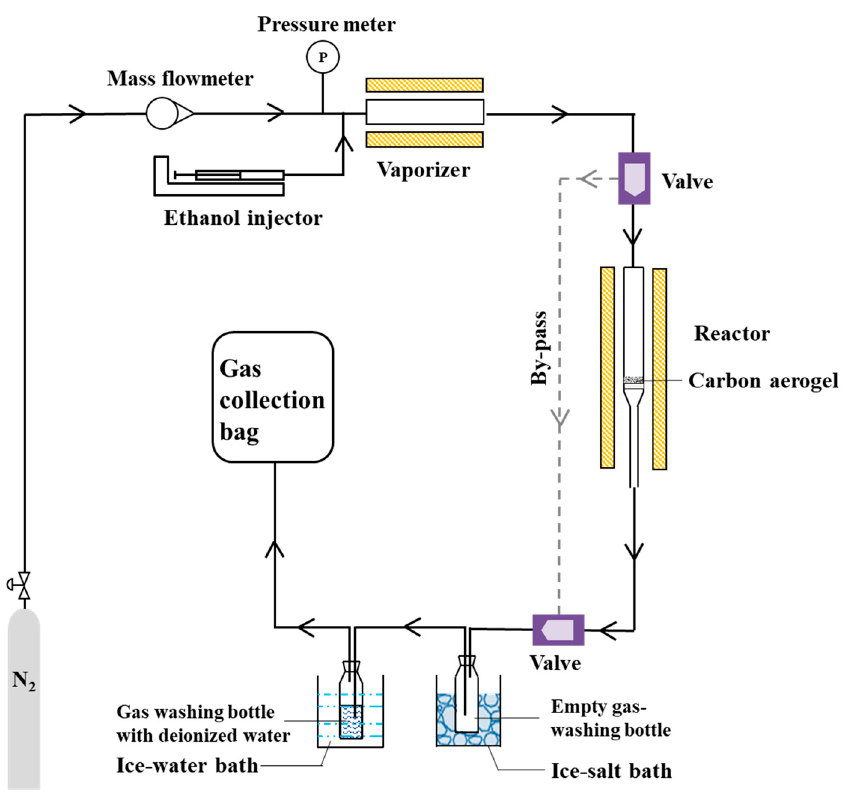
Figure 1. The cracking performance evaluation system for ethanol cracking reaction with CAs.